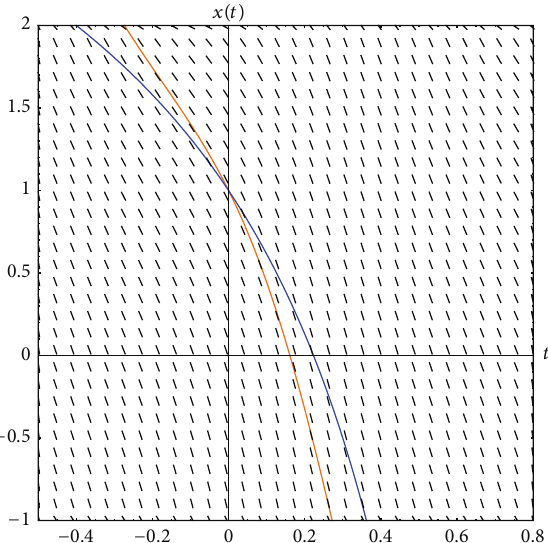
Figure 3: The upper solution (blue) and solution (orange) to (35) Figure 5: The upper solution (blue), lower (purple), and solution satisfying the initial condition 𝑥(0) = 1 . An upper bound for the (orange) to (26), all satisfying the initial condition, 𝑥(0) = 0.5 , and = 0.2229 . extinction time for this solution is 𝑡 s the vertical asymptote for the upper ext